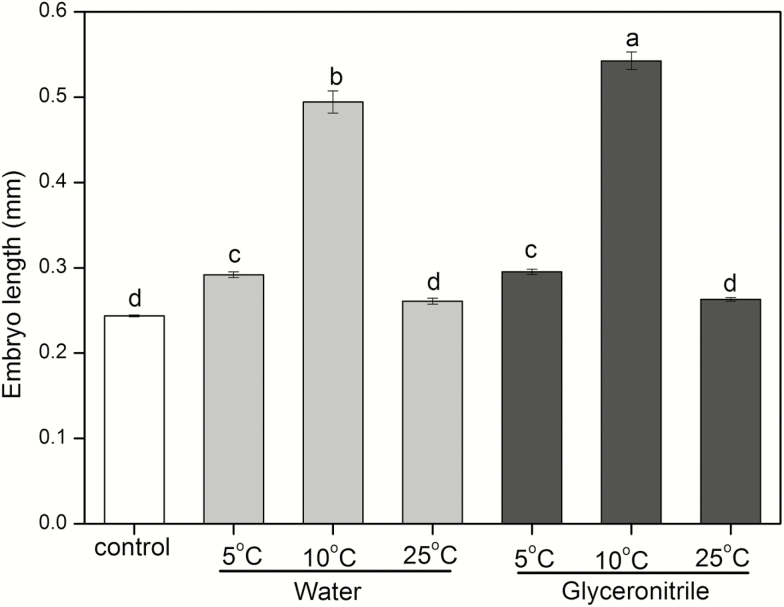
Embryo length (mean ± SE) of after-ripened Anigozanthos flavidus seeds incubated at 5, 10 and 15 °C for 28 days on filter paper moistened with water or glyceronitrile. Control represents mean embryo length of seeds prior incubation. Bars with different letters are significantly different at P < 0.05.